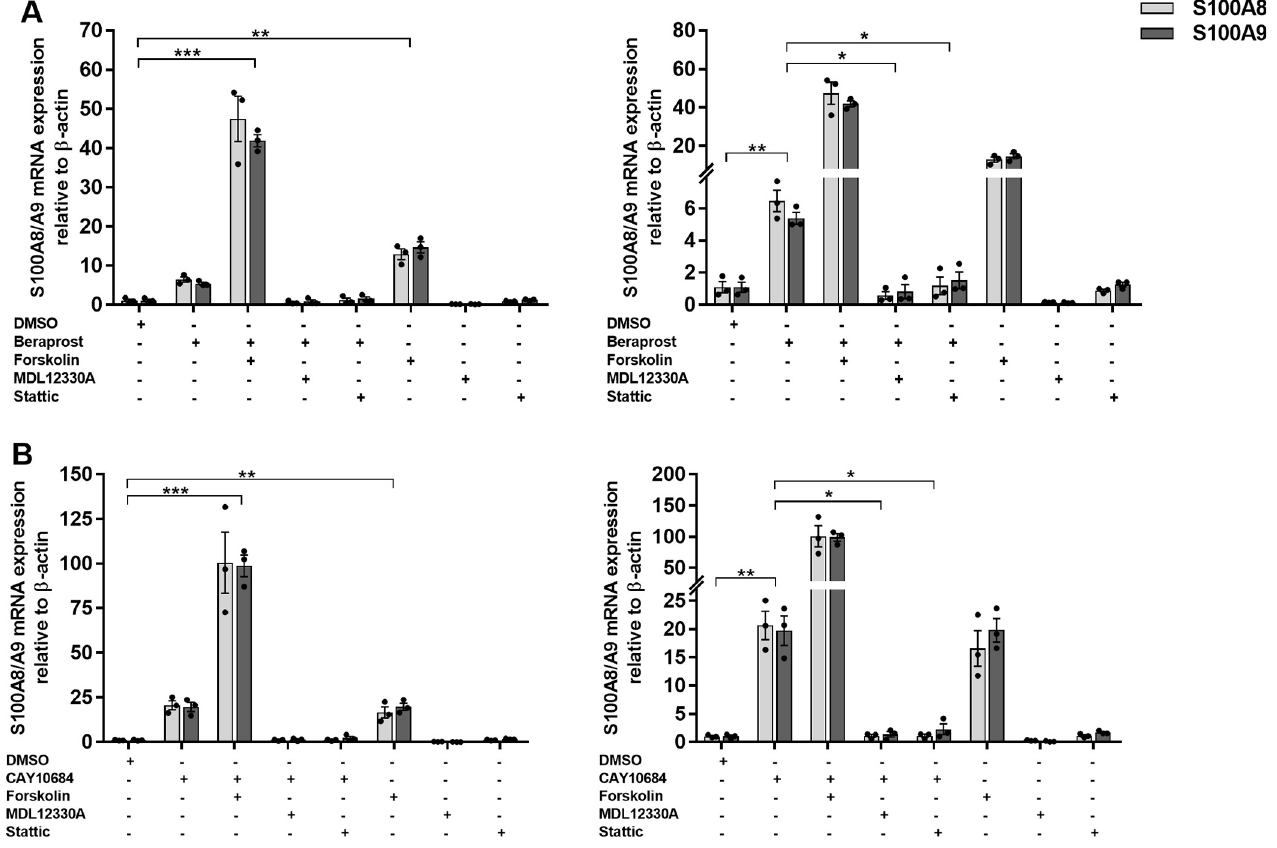
Fig 4. Impact of AC activator/inhibitor and STAT3 inhibitor on the S100A8/A9 expression induction in parental THP-1. Relative mRNA expression levels of S100A8/A9 genes were evaluated after treating 5x10 5 THP-1 cells with either 10 μ M AC activator (Forskolin), 10 μ M AC inactivator (MDL12330A) or 2x10 -5 M STAT3 inhibitor (Stattic) in the presence or absence of (A) 1x10 -5 M PTGIR agonist (Beraprost) or (B) 1x10 -5 M PTGER4 agonist (CAY10684) for 24h. Graphs on the right represents the same data with different y-axis scale. Each bar is the mean of 3 samples from 3 different experiments ± SEM. � P < .05, �� P < .01, ��� P < .001 (Student’s t -test